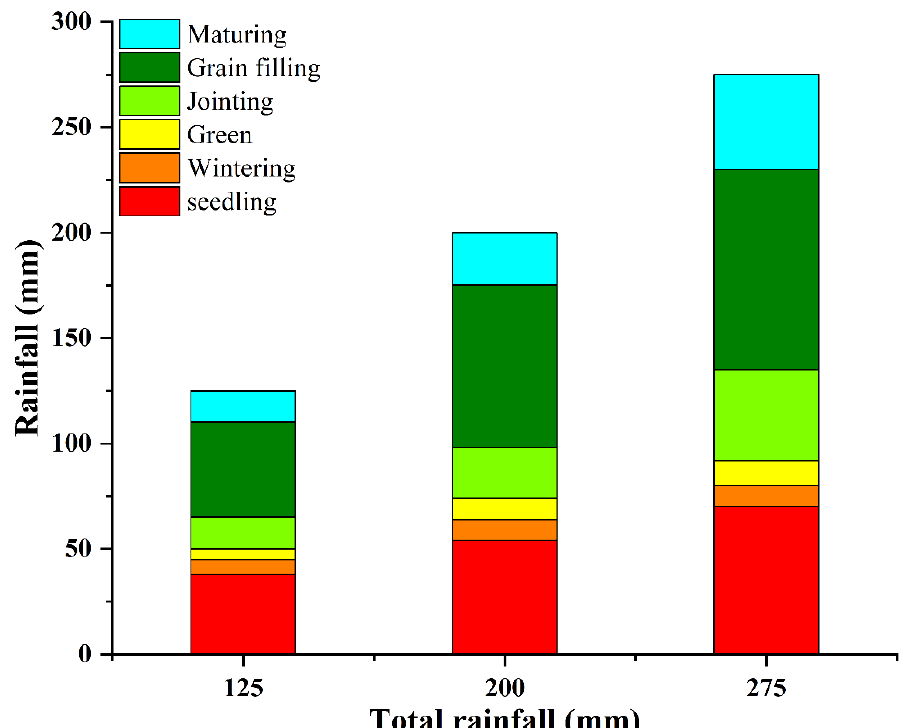
Figure 2. Distribution of simulated rainfall during the winter wheat growing seasons. Note: The seeding period is defined as the time of seed sowing, before seedling emergence; Wintering indicates the mean air temperature is stable at 0–1 °C, and wheat basically stops growing; Green: the temperature rises in the spring of the next year, the wheat leaves change color from green purple to bright green, and some heart leaves are exposed; Jointing: 1.5–2 cm above the ground between the stems of more than 50% of the plants in the field; Grain filling indicates that nutrients are quickly transported to the seeds and accumulate, the particles begin to deposit starch, and the endosperm is condensed milk; Maturing means the grains begin to harden.